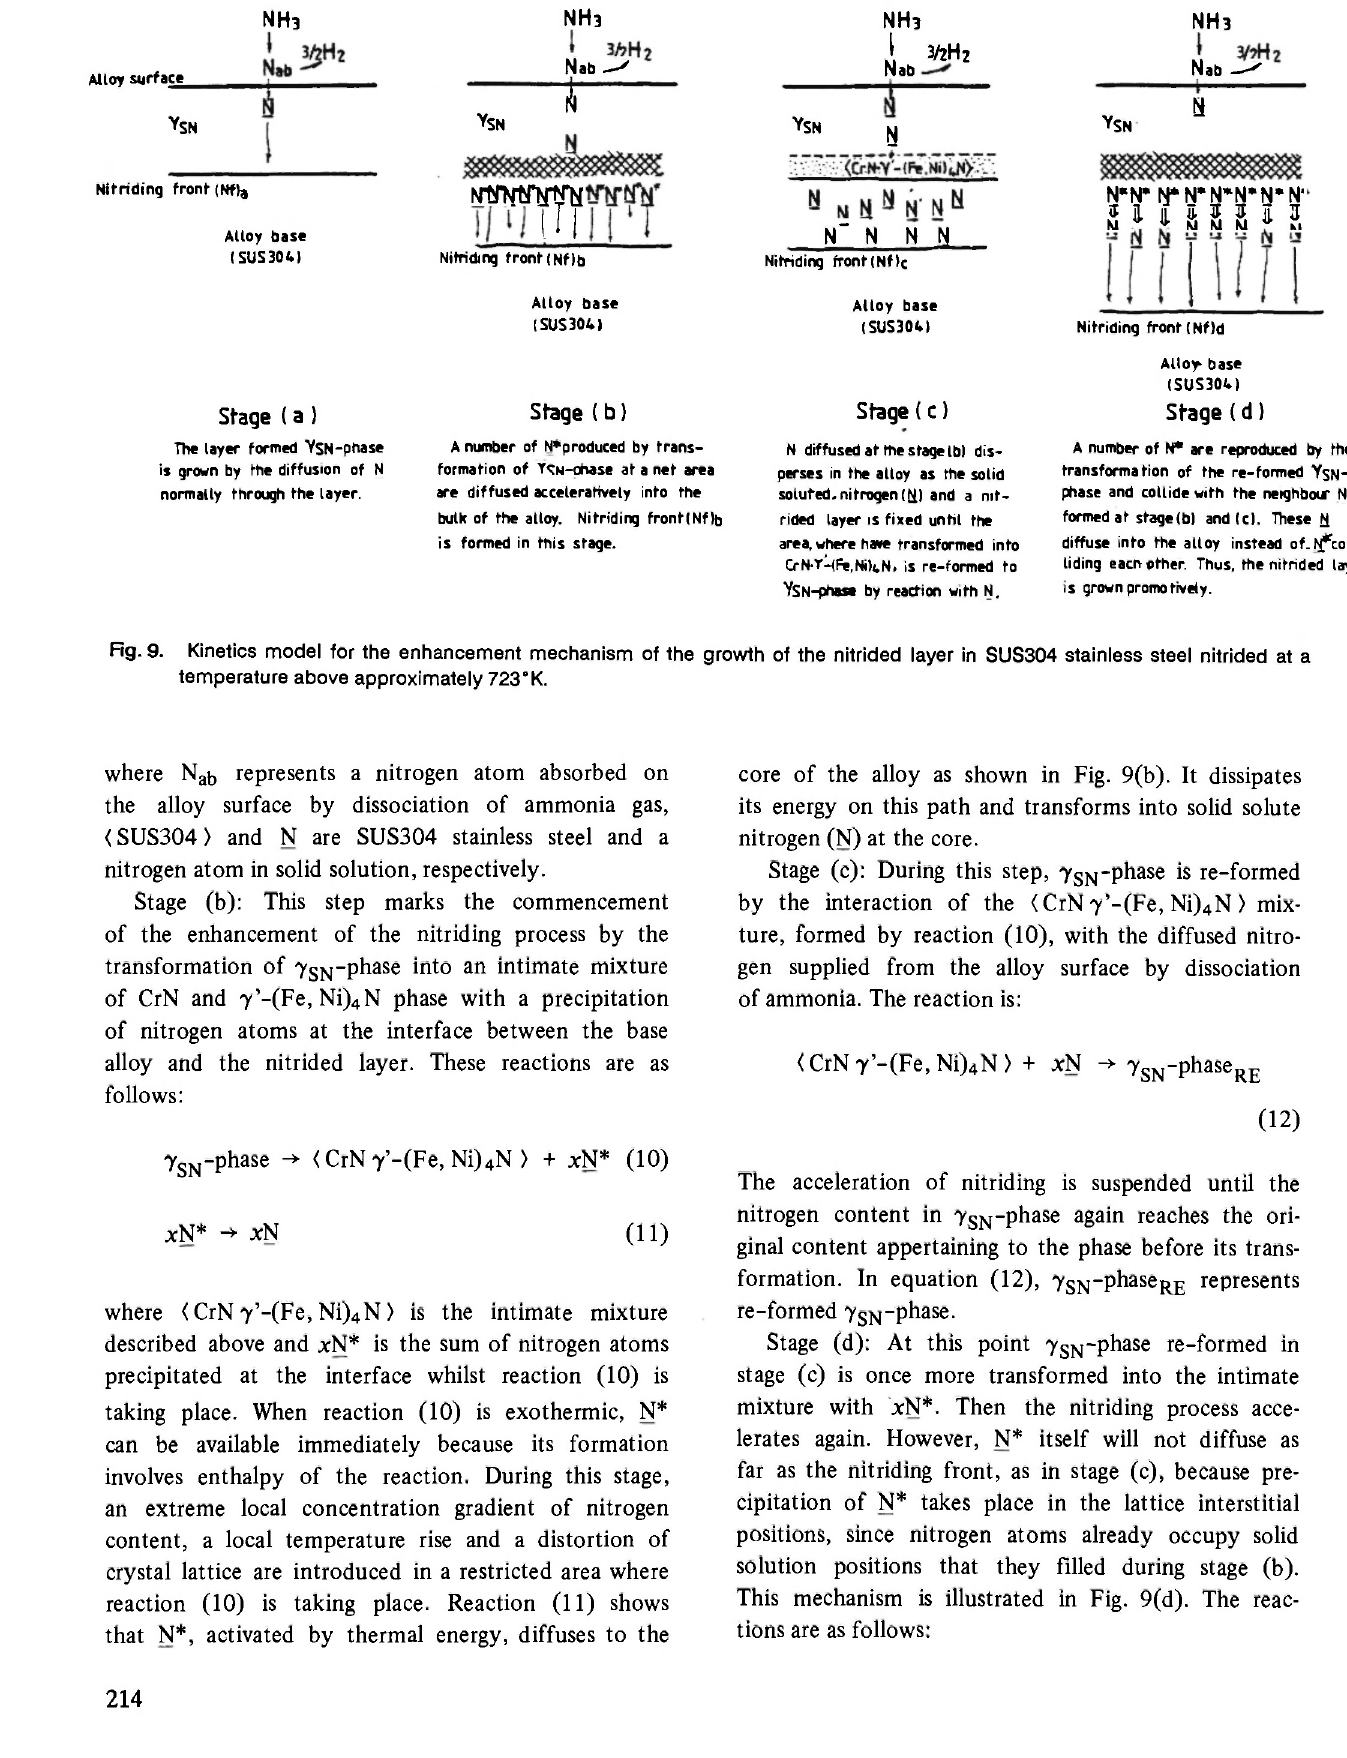
A number of N* are reproduced by the transformation of the re-formed YSN- phase and collide with the neighbour Ν formed at stage(b) and(c). These a diffuse into the alloy instead of.(^col- liding each ether. Thus, the nitrided layer is grown promo tively.